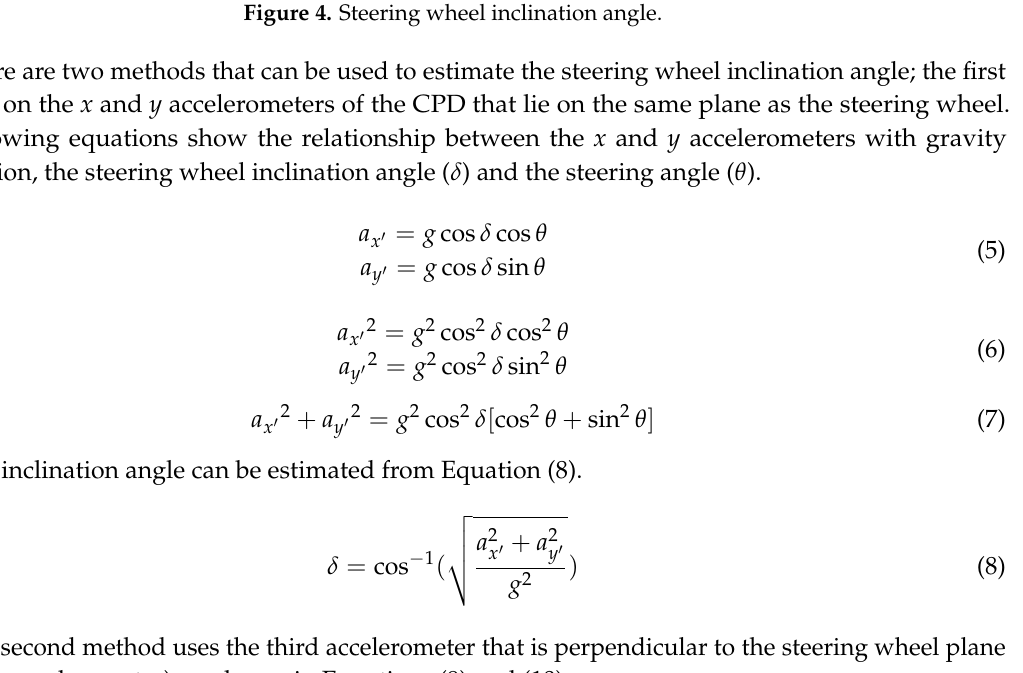
Figure 4. Steering wheel inclination angle.